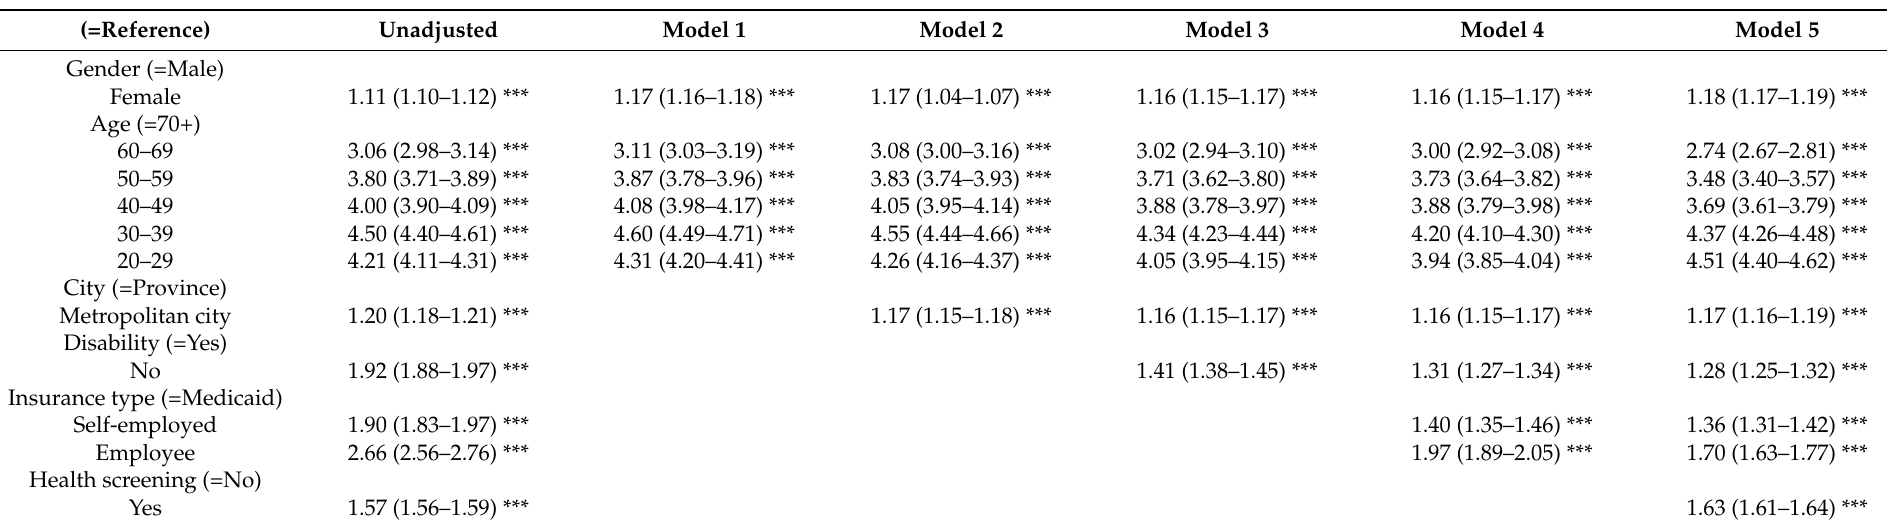
Table 3. Odds ratio (OR) and 95% confidence interval (CI) estimated from logistic regression models for dental scaling in total in the NHISS (N =